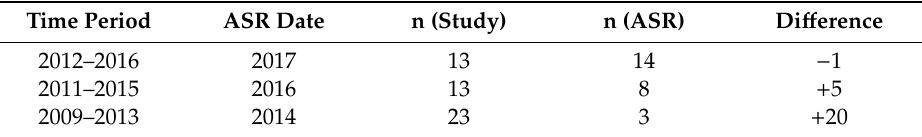
Table 6. Comparison of study data with EASA ASRs.